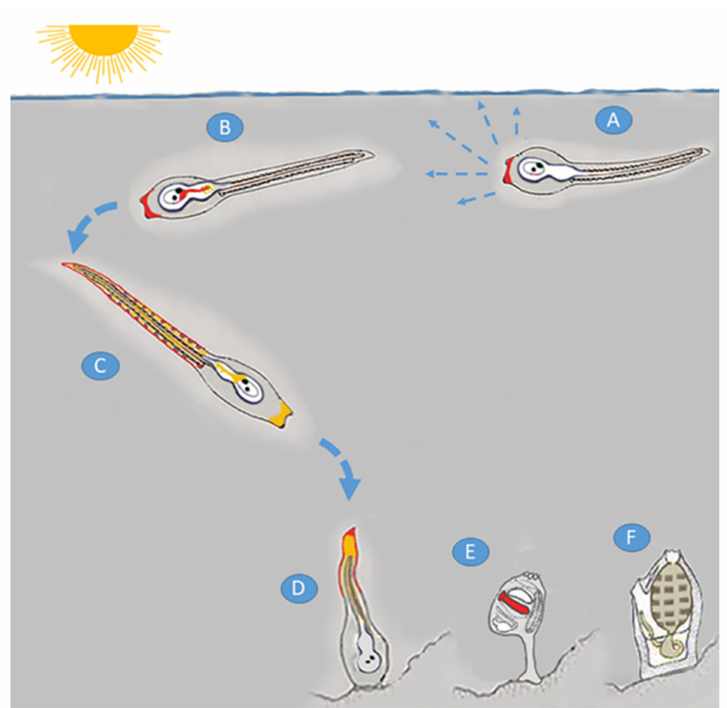
Figure 4. Schematic representation of Ciona larval development and metamorphosis. Just after hatching ( A ), the larva swims randomly in all directions. Nos transcript localization is visible in the palps (shown in red). At mid-larval stage ( B ), NOS transcript and/or protein expression continue to be visible in the palps and a novel signal appears in the CNS (red color). From the mid- to late-larval stage, Ciona becomes photosensitive, changes its swimming behavior, and heads towards the bottom. At the late larval stage ( C ) NOS transcript and protein appear in the epidermis and tail sensory neurons of the PNS. At this stage, only NO is still visible in the palps and CNS (yellow color) and diffuses in mesoderm and notochord. After settlement ( D ), when tail resorption starts, NOS continues to be expressed in the epidermis and NO diffuses not only in the mesoderm and notochord but also concentrates in the reabsorbing tail tip. Nos is visible in the newly formed digestive organ at the juvenile stage (red color) ( E ). Now there is an extensive tissue remodeling, and the replacement of most of the larval tissues with the newly forming organs of the adult ( F